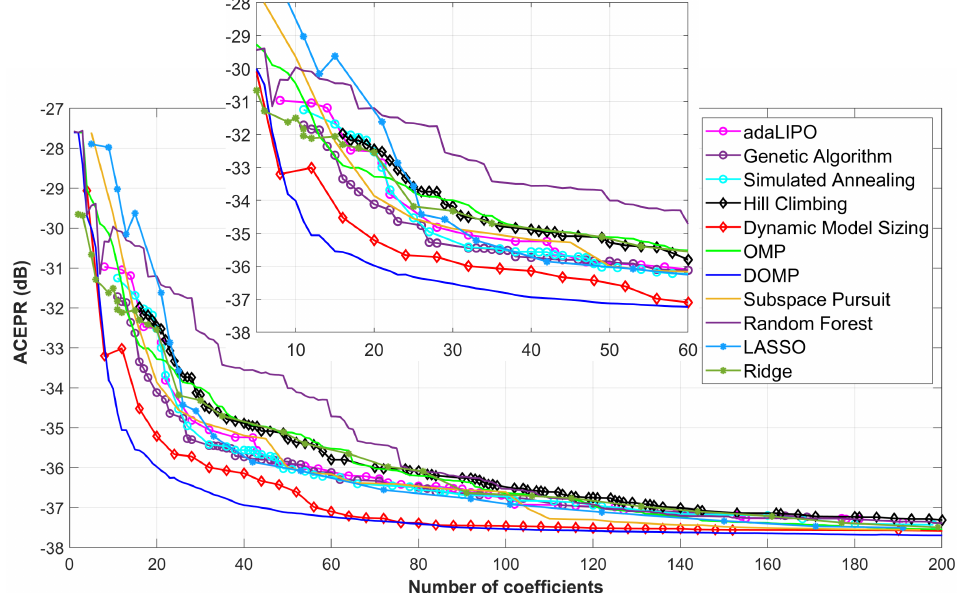
Figure 6. ACEPR versus the number of coefficients when considering different feature selection